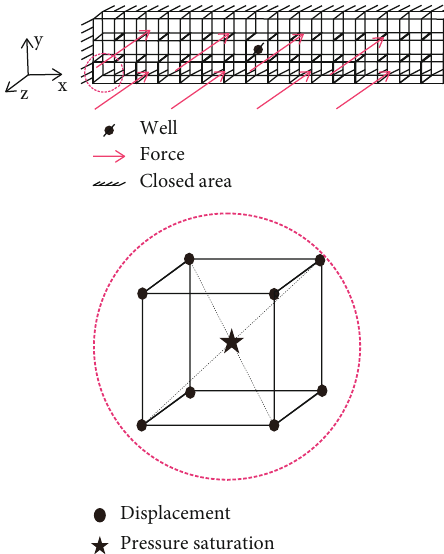
Figure 1: The locations of pressure, saturation, and displacement in the cell.